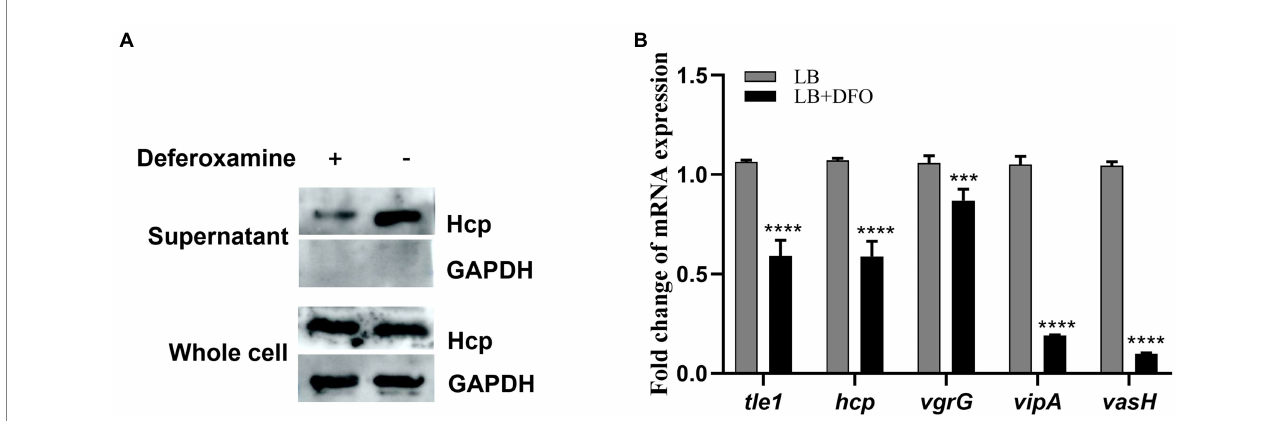
FIGURE 1 T6SS is repressed under iron-depleted conditions in Aeromonas hydrophila . (A) The expression and secretion of Hcp were analyzed by western blot. An anti-GAPDH antibody was used as control. (B) RT-qPCR analysis of the transcripts of the T6SS core genes in iron-depleted medium, presented relative to the expression in LB medium. The error bars represent mean ± standard deviations from three independent experiments (*** p < 0.001; **** p < 0.0001).